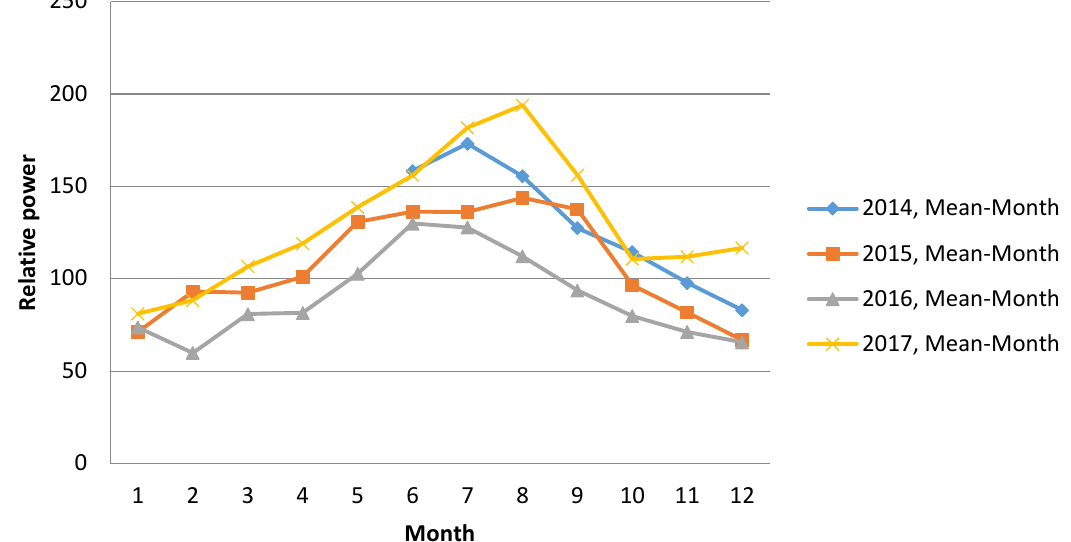
Figure 1. The changes of power of local Earth’s magnetic field in Lithuania (GCI003) during 2014–2017 years.